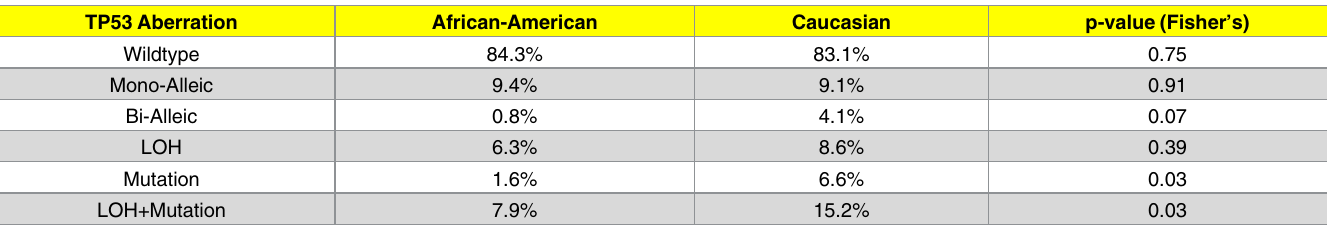
Table 1. TP53 mutation